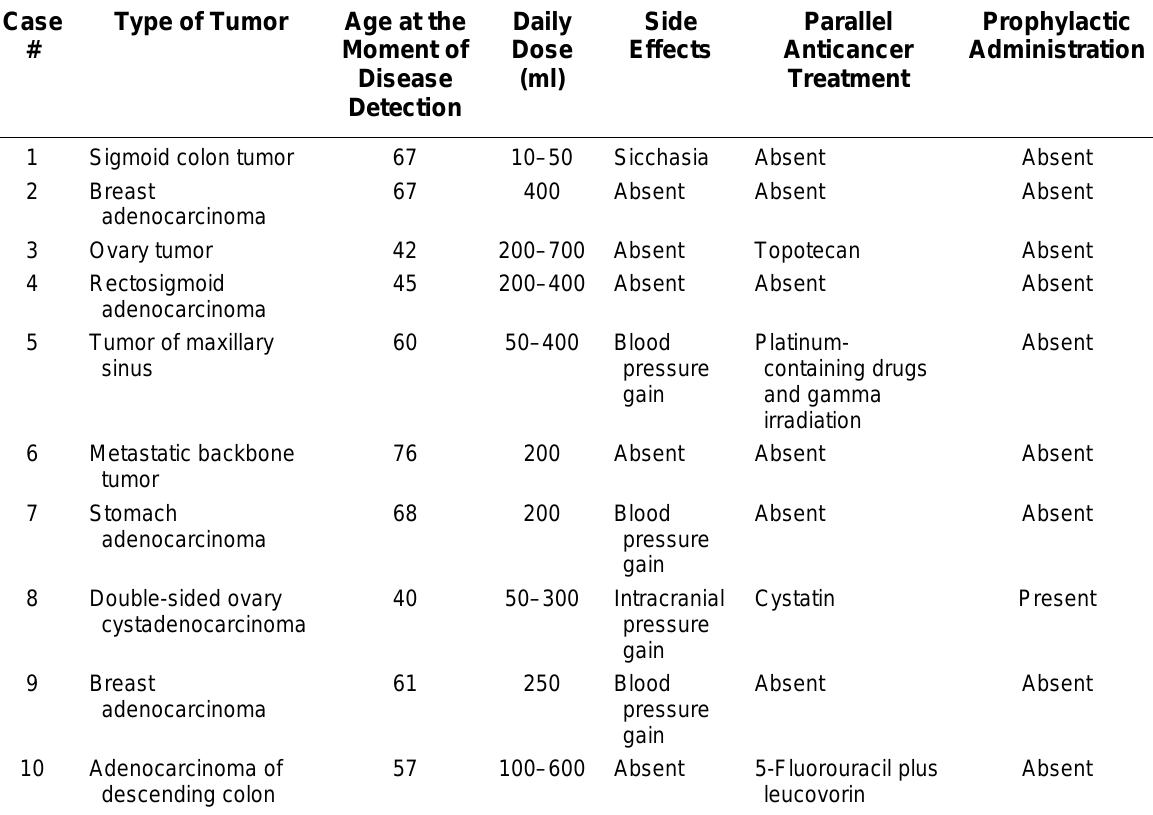
Some Key Information on Patients Under